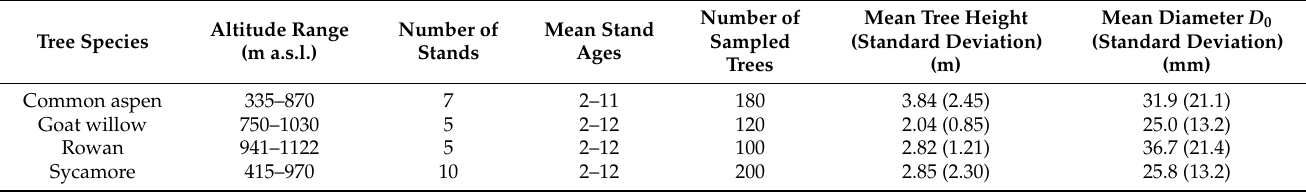
Table 5. Main characteristics of sampling locations and sampled trees of investigated broadleaved species.